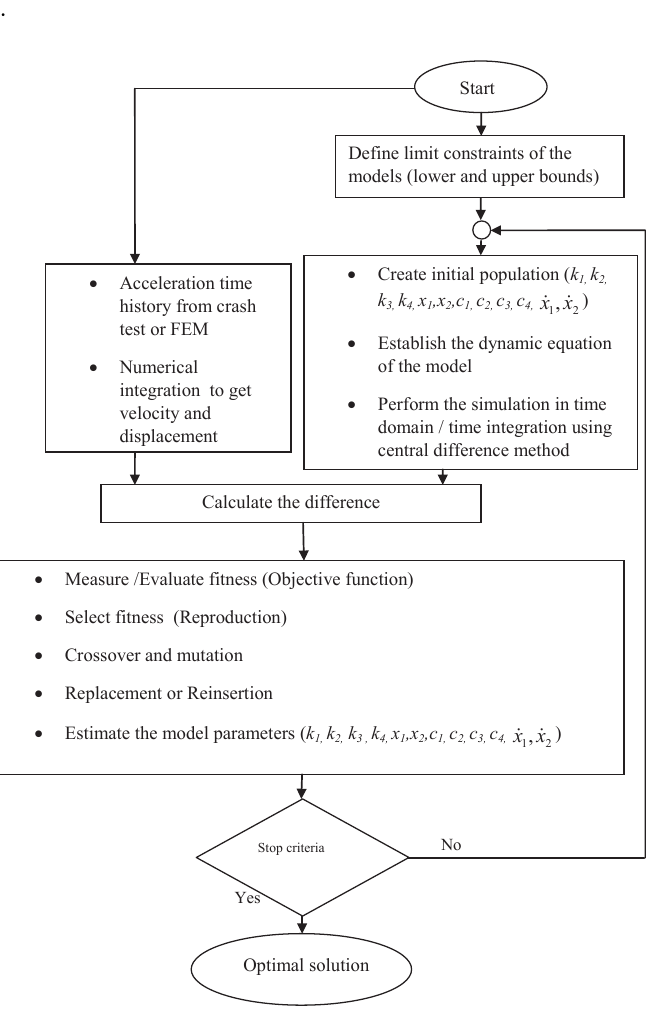
Figure 4. Calibration procedure using genetic